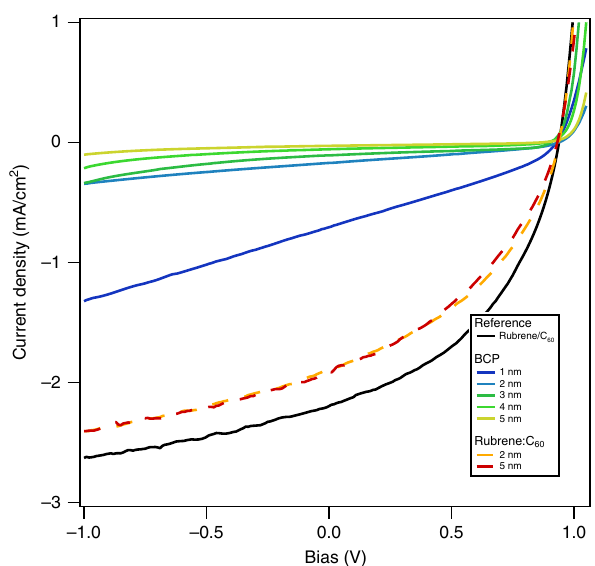
Fig. 4 OPV device characteristic. J(V) -characteristics of rubrene/C 60 devices operated as solar cells with BCP or rubrene:C 60 interlayer thicknesses between 1 and 5 nm under AM1.5 conditions. For comparison, a reference heterojunction rubrene/C 60 without the either of the two interlayers is